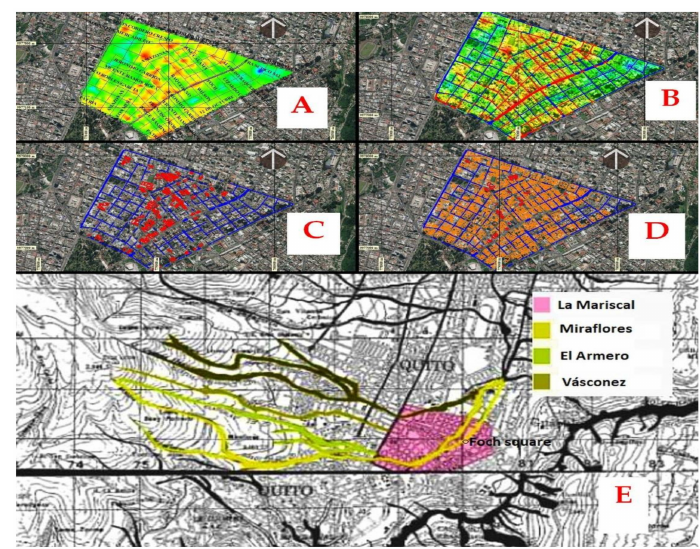
Figure 13. ( A ) All exposure of street. ( B ) Exposure streets with red and non-exposure streets in blue. ( C ) Street vectors with high to very high exposed. ( D ) Streets vectors of medium, high and very high exposure. ( E ) The full ravines and the position of the Foch square. The image is of low resolution from its origin